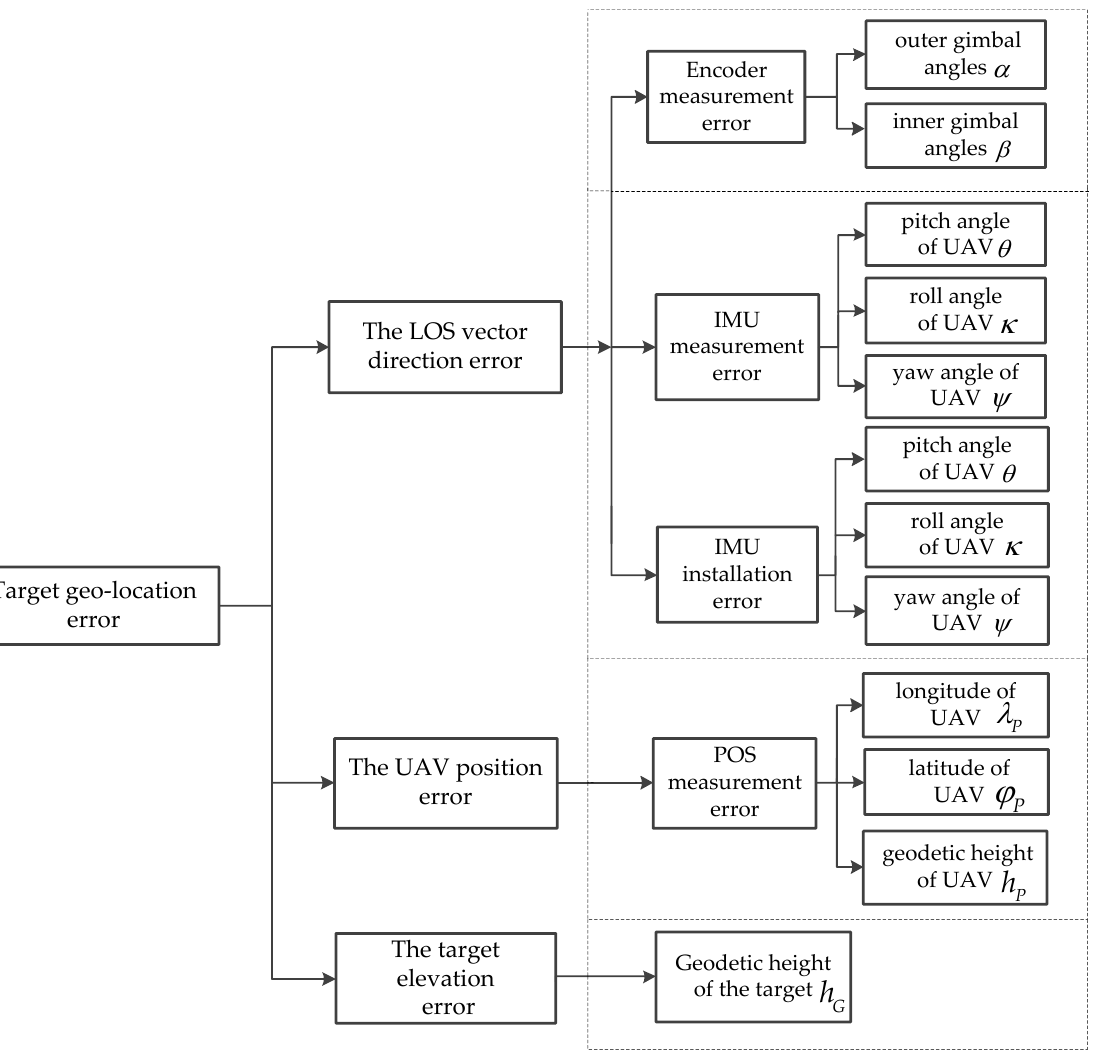
Figure 2. The error sources affecting the geo-location accuracy. In order to intuitively illustrate the influence of the measurement variances and target elevation error on the geo-location accuracy of LRORS, we conducted comparative analysis on the geo-location accuracy when the off-nadir looking angle was 0 ◦ , 35 ◦ , and 75 ◦ , respectively. The measurement variances in the geo-location are shown in Table